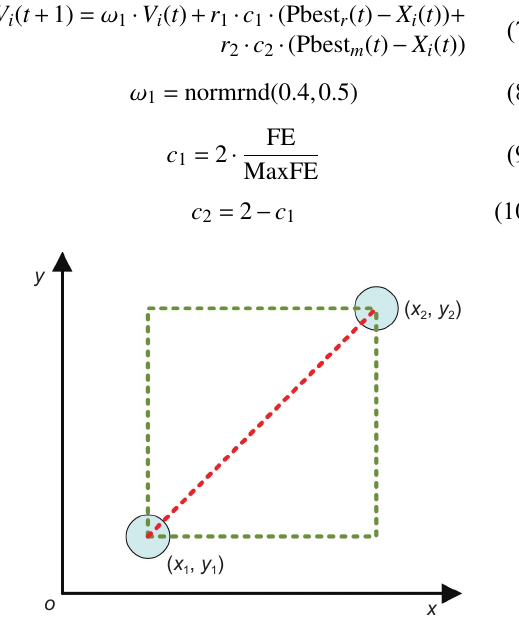
Fig. 2 Illustrations of Manhattan distance.